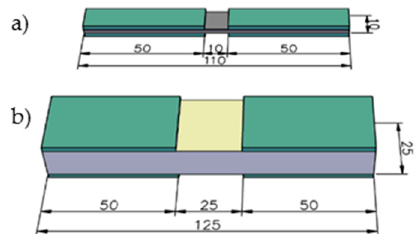
Figure 2. Geometry of typical compression specimens (dimensions in mm); ( a ) for the first and second stages of research, and ( b ) for face laminate.